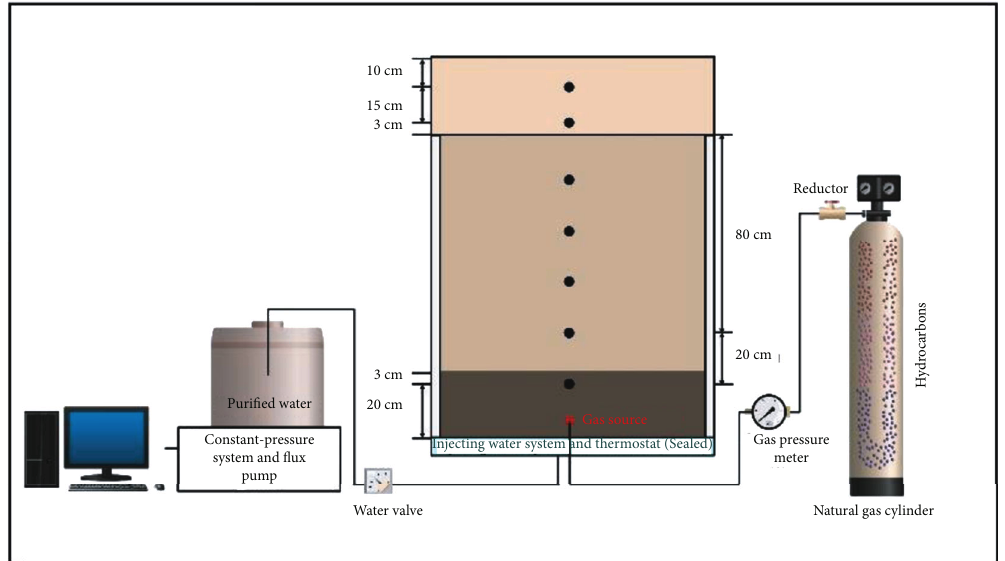
Figure 4: Sketch of the experimental